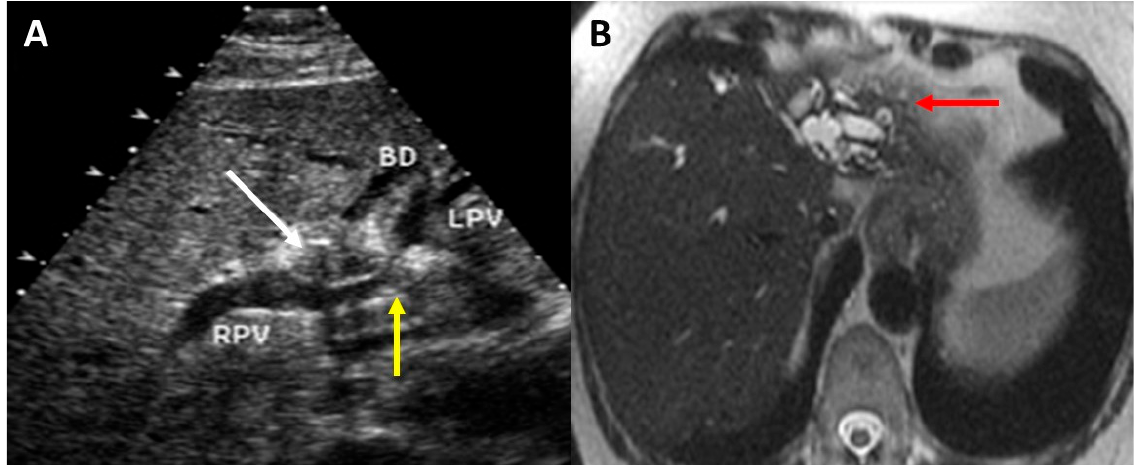
Figure 1. Lobar atrophy associated with perihilar cholangiocarcinoma. Preoperative ultrasonography ( A ) demonstrating perihilar biliary mass ( white arrow ) with resultant narrowing of the left portal vein ( yellow arrow ). MRI ( B ) demonstrated substantial left lobar atrophy ( red arrow ).